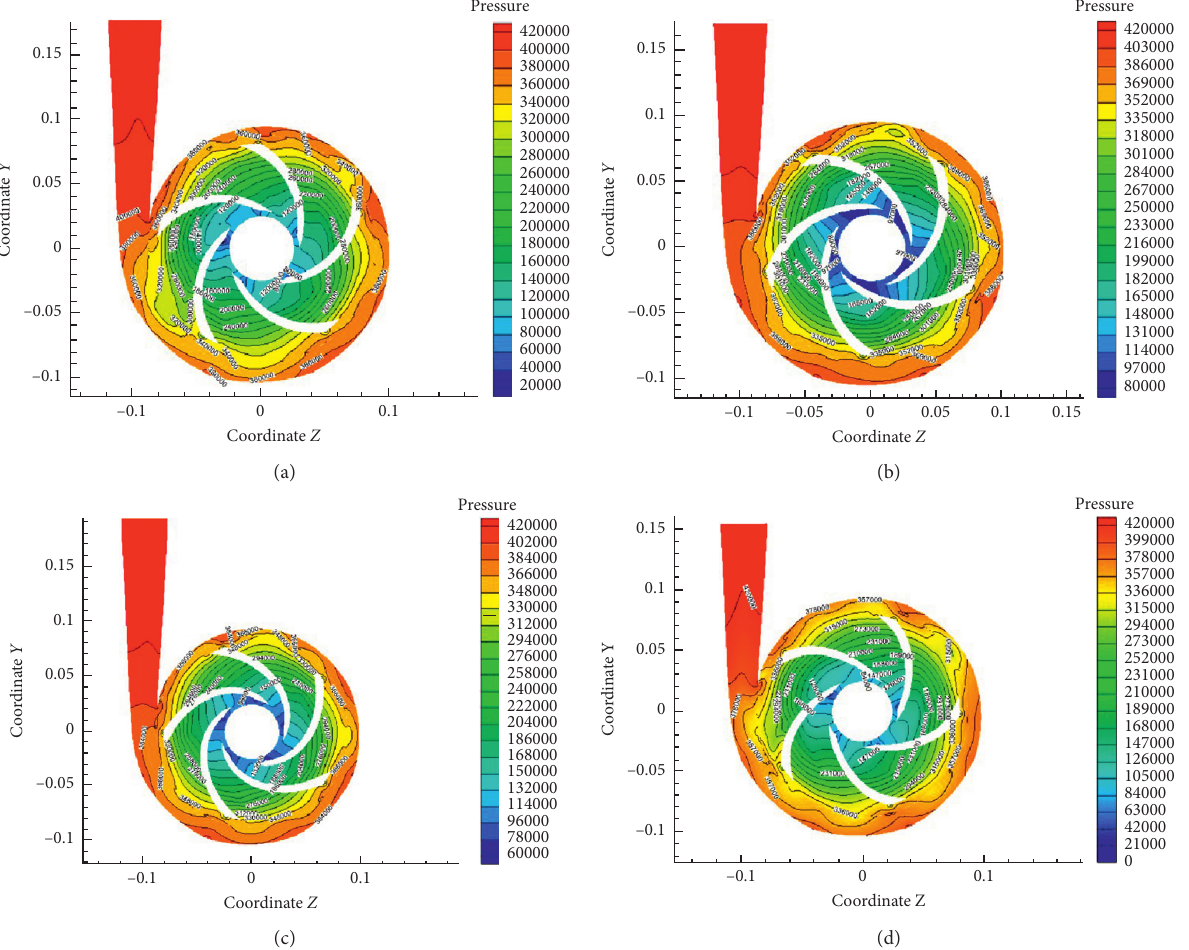
Figure 16: Contours of the pressure of the four impellers. (a) Single arc. (b) Double arc. (c) Logarithmic spiral. (d) B-spline